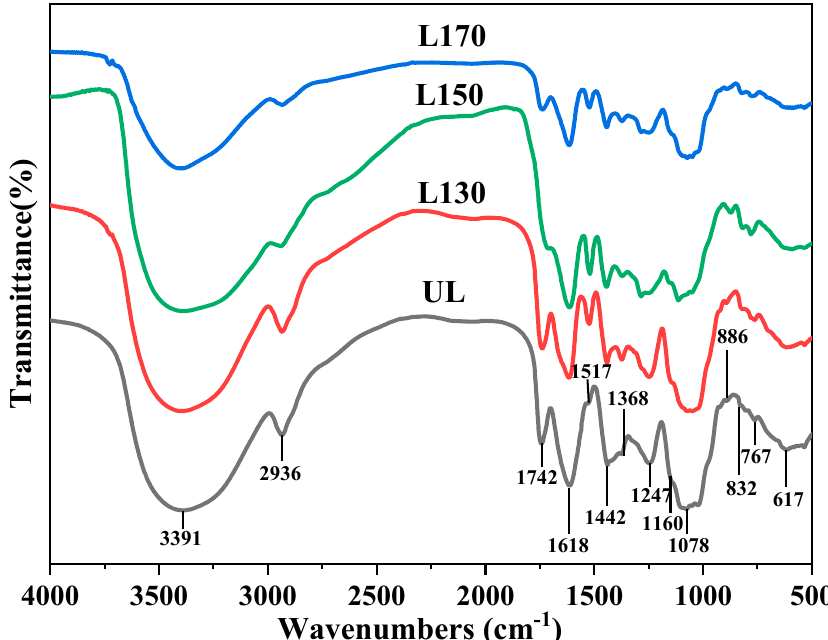
Figure 2. FT-IR spectra of UL, L130, L150, and L170 fractions.